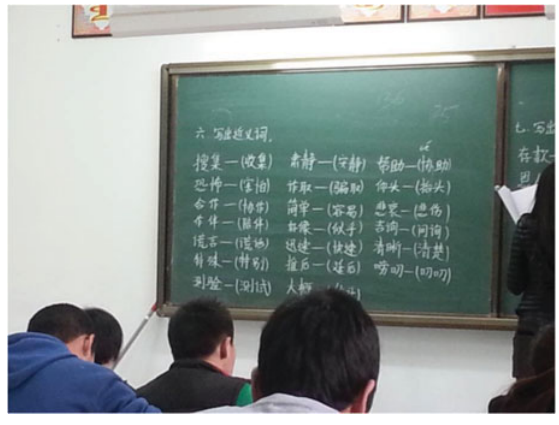
FIGURE 3 (Colour online) Track 1 in the Bilingual